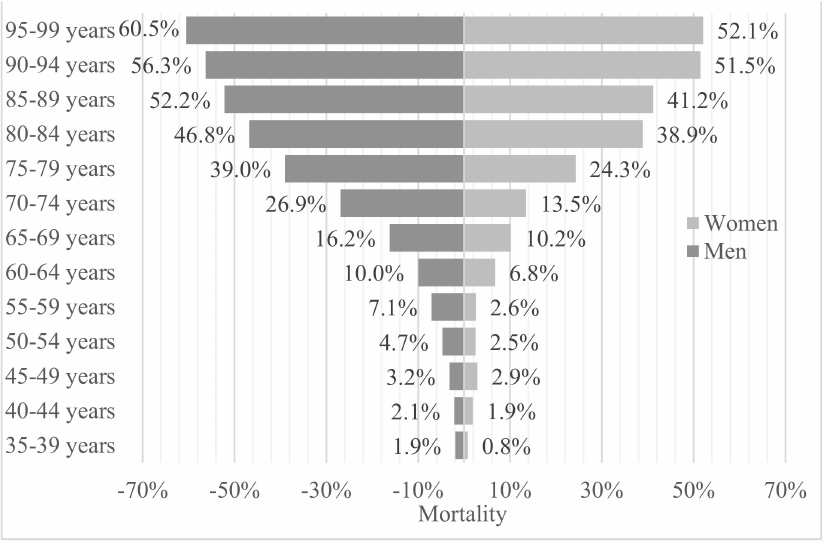
Figure 2. Mortality between the sexes according to age range.